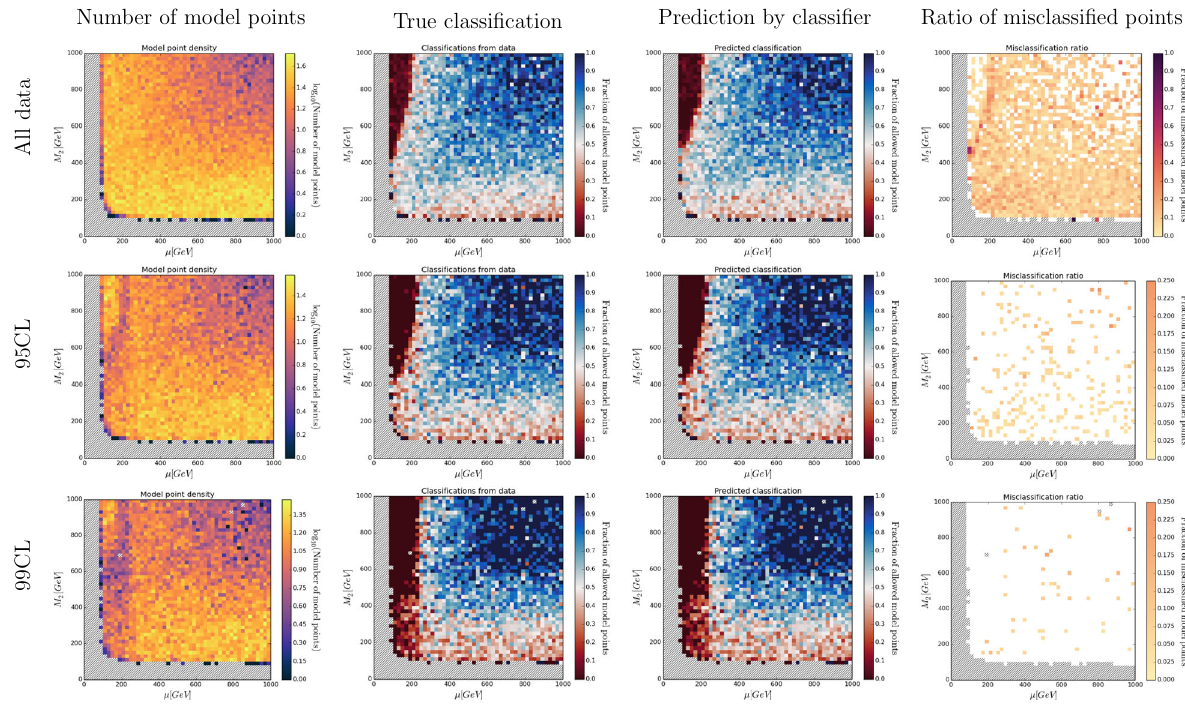
Fig. 18 Color histograms for a projection of the 19-dimensional pMSSM parameter space on the μ – M 2 plane. The color in the second and third column indicates the fraction of allowed data points for the